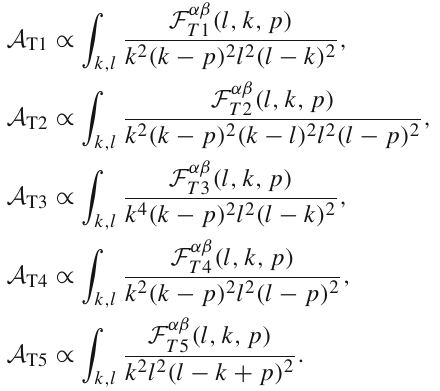
Therefore, in this contribution we will only deal with two- point functions with the photon (scalar/spinorial QED) or the gluon background field (Yang–Mills and QCD) as external legs. This implies that only the topologies depicted in Fig. 2 can